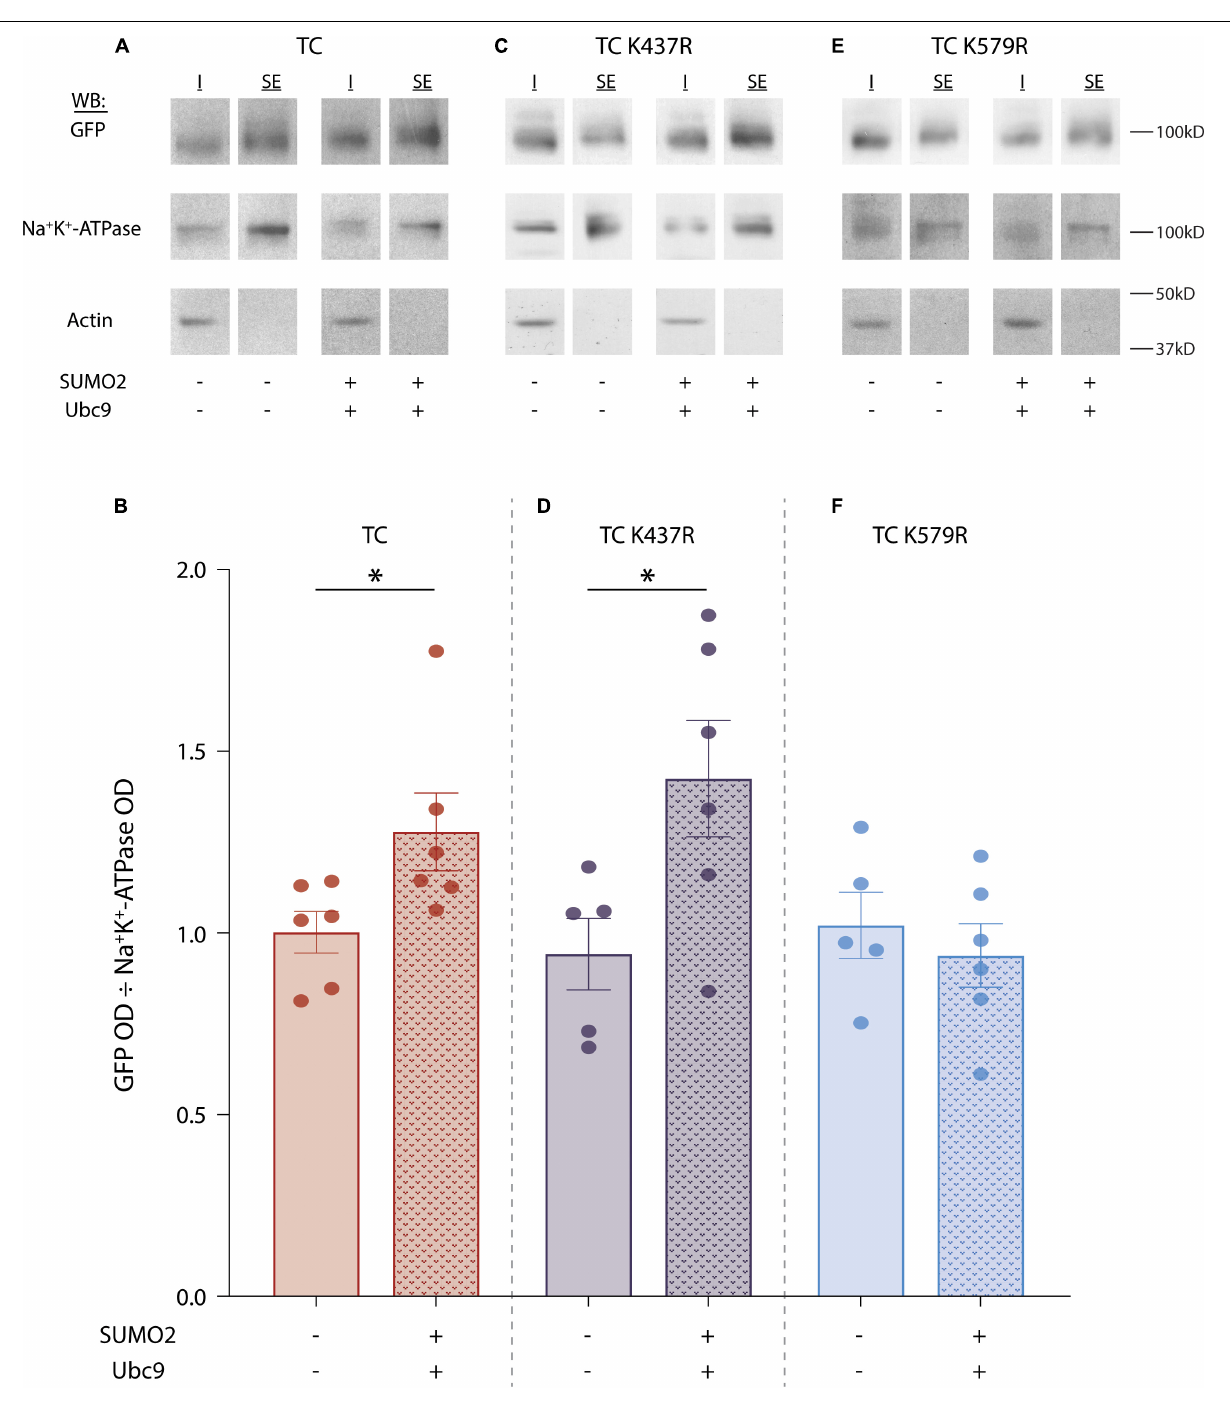
FIGURE 5 | SUMOylation of Kv4.2g at K579 increases surface expression. SUMOylation was (+) or was not (–) increased in HEK cells expressing wild-type TC, TC K437R, or TC K579R. Surface proteins were biotinylated, cells were lysed, and surface expressed fractions (SE) were isolated using NeutrAvidin resin. Proteins that did not bind to the NeutrAvidin resin were considered to be the intracellular fraction (I). (A,C,E) Western blots containing SE and I from one representative experiment for each treatment group. The upper portion of the blot (above 50 kD) was used to visualize Kv4.2g with anti-GFP; it was then stripped and re-probed with anti-Na + /K + -ATPase. The lower portion of the blot (below 50 kD) was probed for actin. (B,D,F) Bar graphs showing the mean ± SEM Kv4.2g surface expression [SE Kv4.2g OD/SE Na + /K + -ATPase OD]. Each dot is one independent experiment. Asterisk, significantly different. TC: control, 1.0 ± 0.1 vs. SUMO2 +